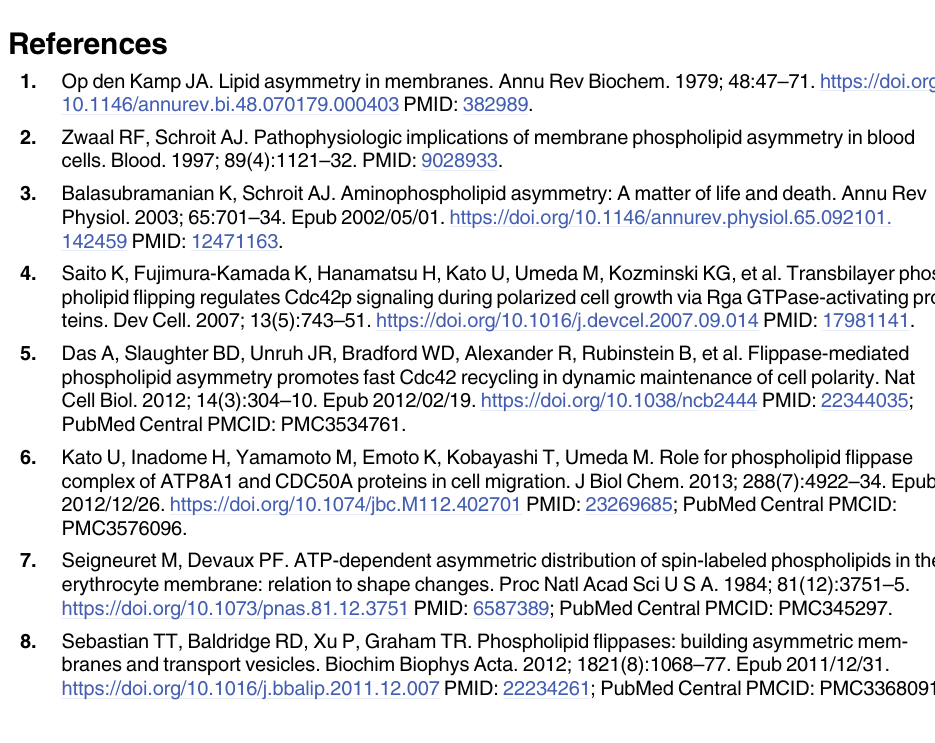
S1 Table. Saccharomyces cerevisiae strains used in this study. (PDF) S2 Table. Plasmids used in this